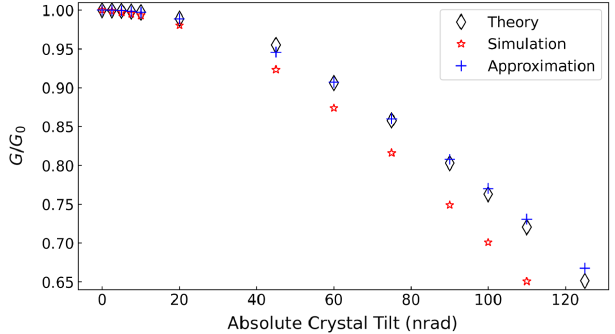
FIG. 6. Comparison of normalized gain values obtained from simulations, calculated gain formulas of Eq. (23), and approxi- mate gain formulas of Eq. (25) for steady-state coordinates of the radiation beam obtained from